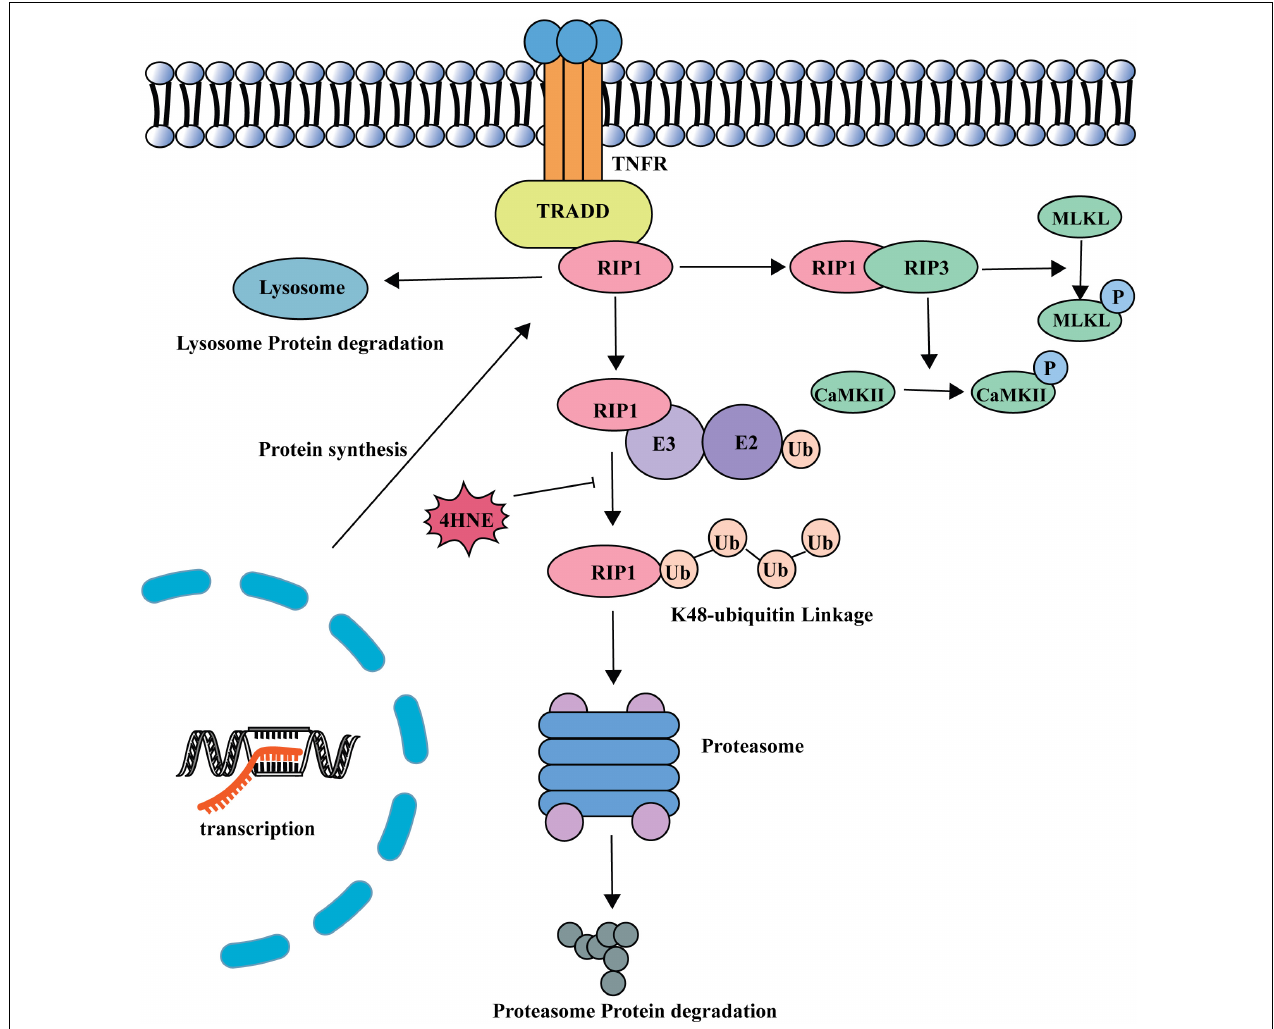
FIGURE 7 | A model of the role of 4-HNE in regulating cardiomyocyte necroptosis during